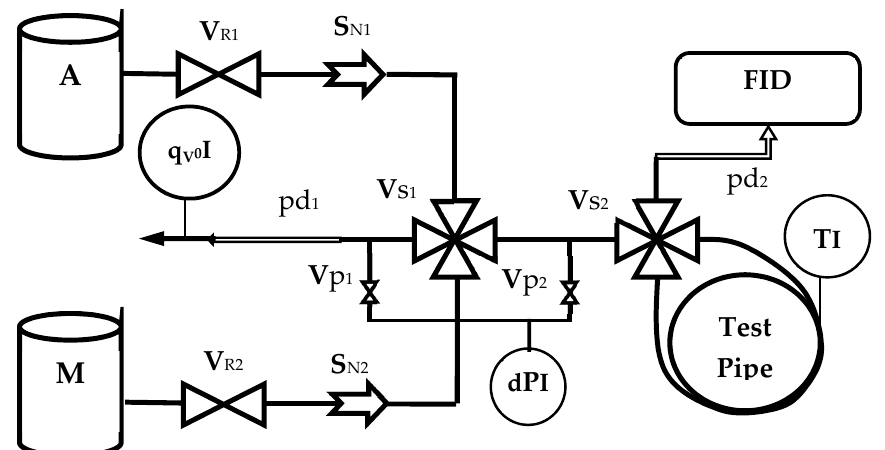
Figure 1. Scheme of the experimental setup. (V R : Pressure reducing valve; V S : 4-way Switch valves; V p : interception valve; FID: Flame Ionization Detector; SN: Sonic Nozzle; pd: Capillary pipe; q V0 I: Mass Flowmeter; A: Zero Air Cylinder; M: VOC Mixture Cylinder; dPI: Pressure Indicator; TI: Temperature Indicator.).